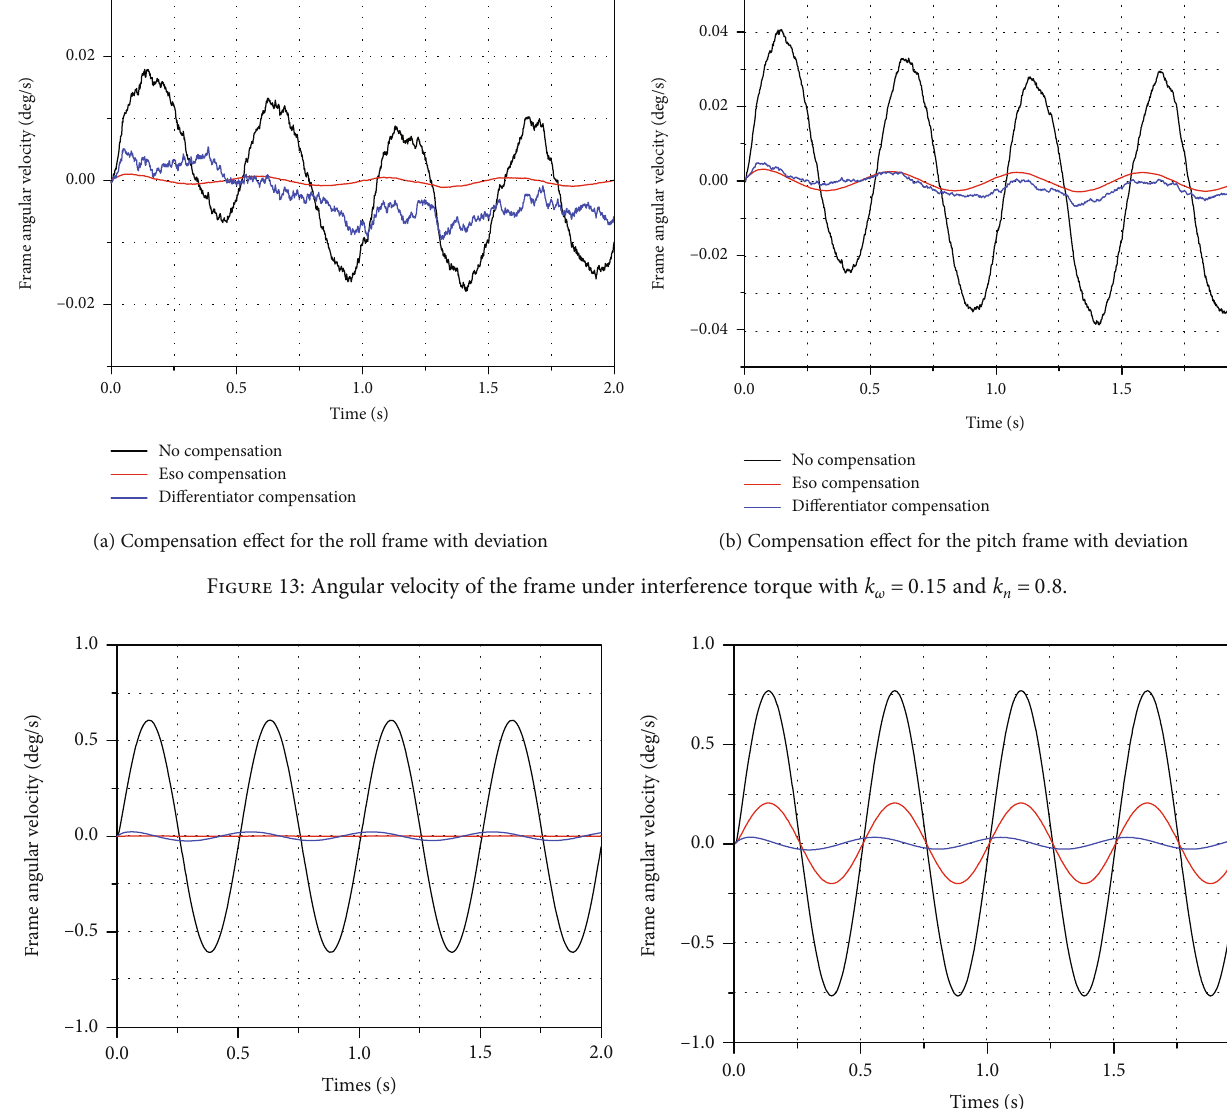
Figure 14: Angular velocity of the roll frame by the use of ESO compensation and feedforward compensation.